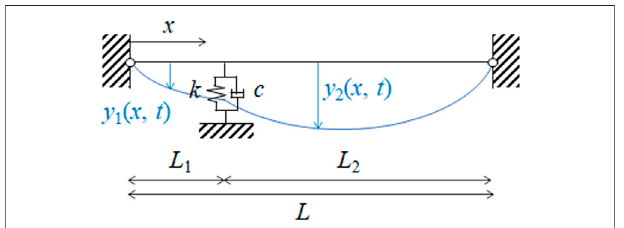
FIGURE 1 | Model of cable with